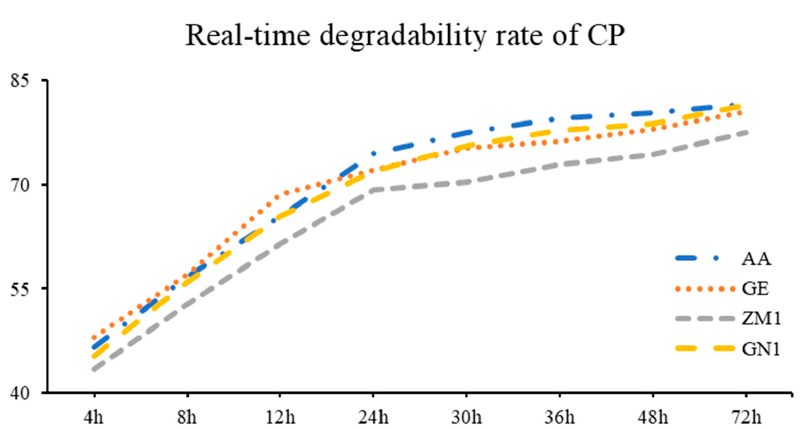
Figure 1. The real-time degradability rate of CP in different alfalfa hay cultivars. AA: American Anderson, GE: American Golden Empress, ZM1: Zhongmu No. 1, GN1: Gongnong No. 1.